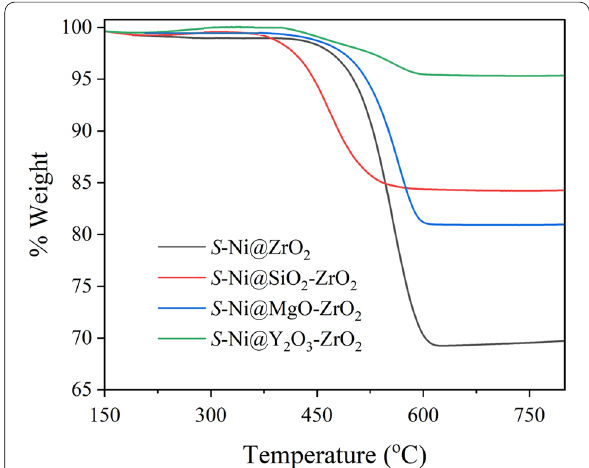
Fig. 8 TGA profiles of spent catalysts for S -Ni@ZrO 2 , S -Ni@SiO 2 -ZrO 2 , S -Ni@MgO-ZrO